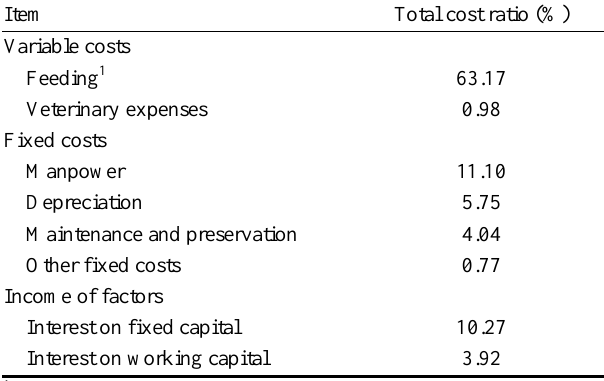
Table 4. Proportion of each cost item in the total